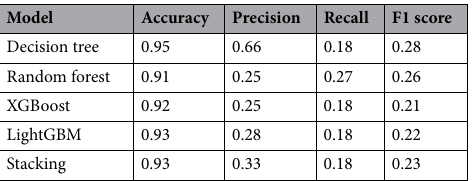
Table 3. Performance results for the machine learning models.